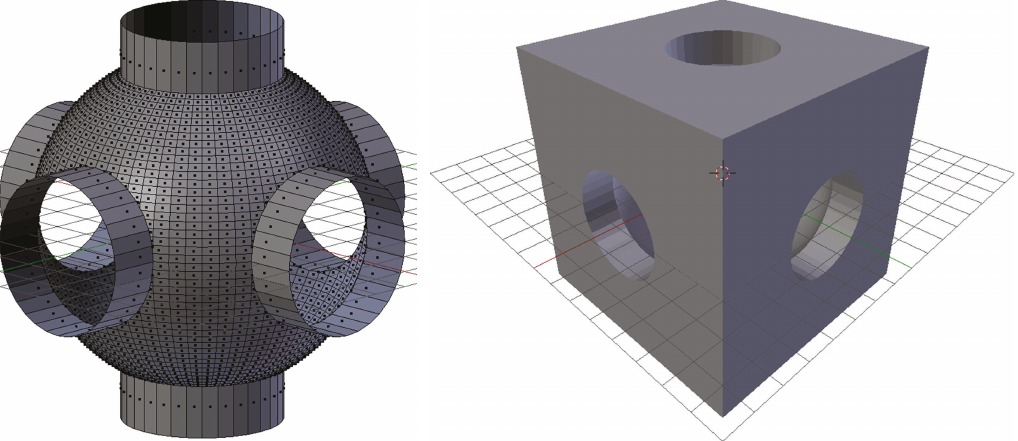
Figure 2: DENORMS benchmark